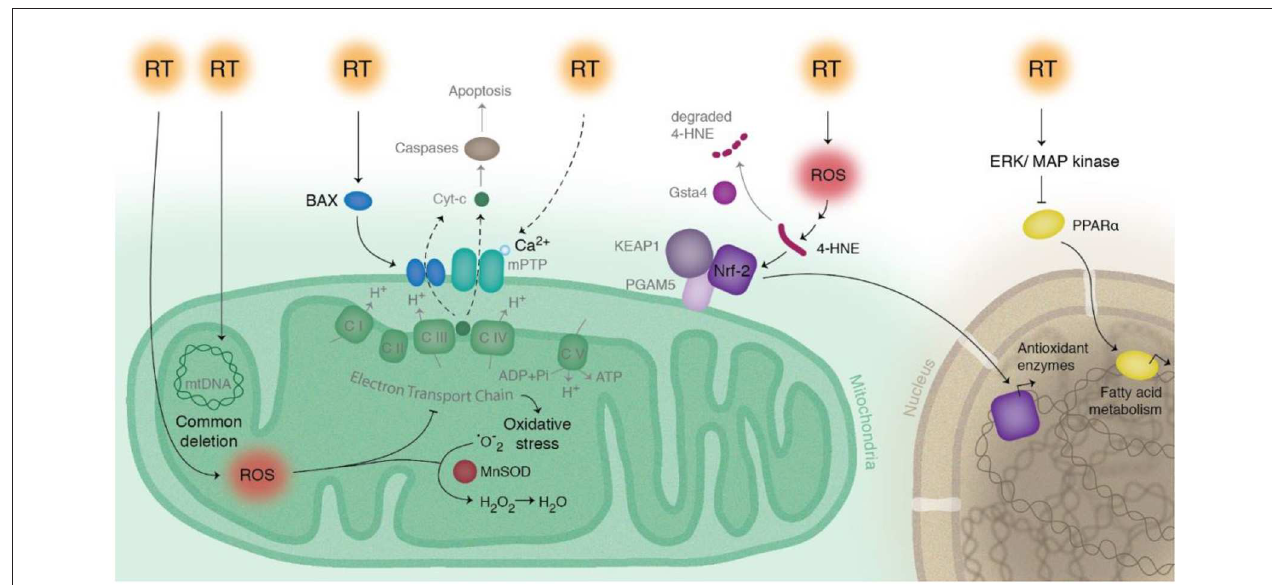
FIGURE 1 | Schematic of radiation-induced effects on pathways related to mitochondria in cardiac cells. Radiation therapy (RT) directly modifies mitochondrial DNA, as seen most notably with the common deletion mutation. RT also indirectly modifies mitochondrial dysfunction by production of reactive oxygen species (ROS), leading to a disruption in the electron transport chain and increased levels of 4-HNE and increased production of antioxidant enzymes via Nrf2. Manganese superoxide dismutase (MnSOD) decreases ROS concentrations by converting superoxide (O − 2 ) to hydrogen peroxide (H 2 O 2 ). RT decreases fatty acid energy production via activation of ERK/MAP kinase pathway, which inhibits PPAR- α . RT causes activation of Bax and release of cytochrome c, initiating the intrinsic pathway of